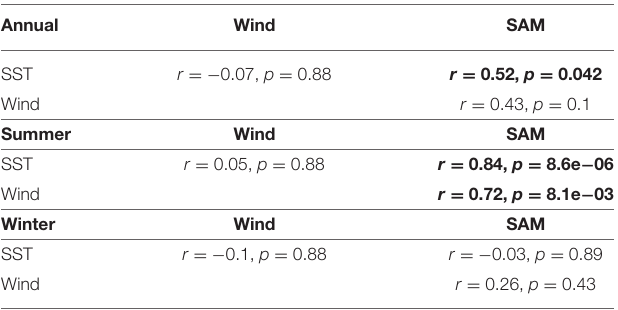
TABLE 3 | Correlation analysis between environmental anomalies (as moving averages).